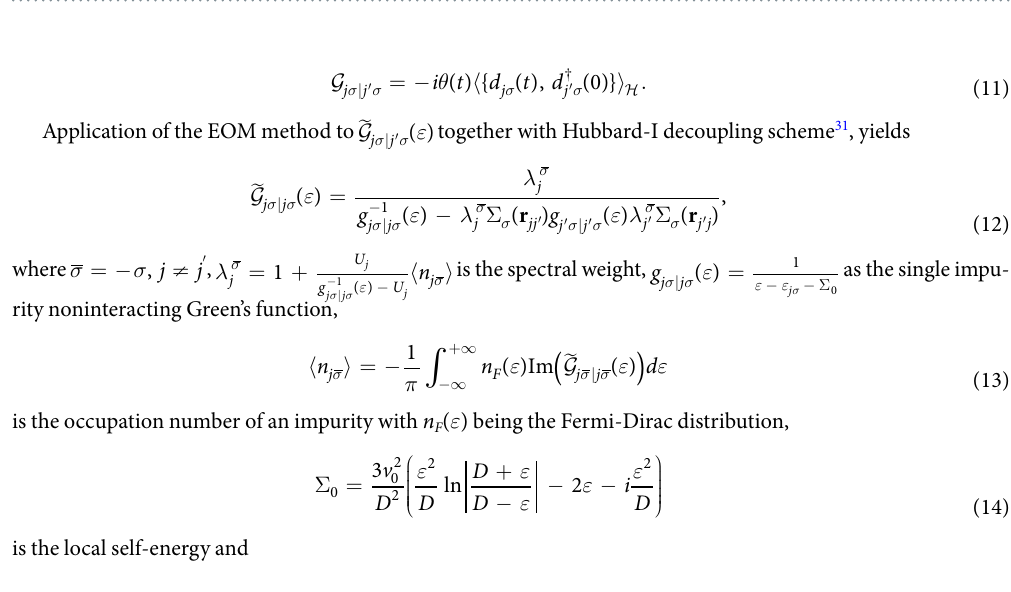
Figure 5. Panel (a) Total magnetization of the impurities as function of the parameter Q y describing the shift of the Weyl nodes in the reciprocal space in the direction parallel to the line connecting impurities. Panels (b,c) = surface for the energies corresponding to bonding and The maps of the total LDOS on the x y r ( , , 1) nm m antibonding states in the valence band for the spin degenerate case corresponding to Q y = 0.157. Panel (d) Spin resolved LDOS at the point = r (1, 1, 1) nm for spin degenerate case ( Q y = 0.157) and maximal spin up m ( Q y = 0.015) and spin down ( Q y = 0.142) polarizations. The LDOS for Q y = 0.157 is rescaled by the factor of 5. The insets highlight the marked sectors. Panel (e) illustrates how molecular orbitals presented in the panels (b and c) are formed from atomic orbitals presented in the Fig.